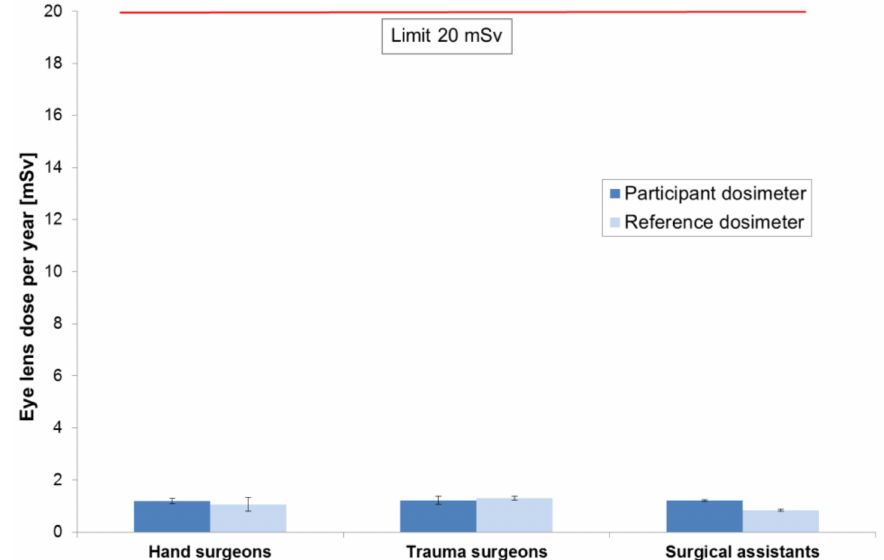
Figure 8. The mean of eye lens dose of the three participant groups (mid-blue) before deduction of the zero e ff ect (measuring point measuring institute LPS) each compared to the mean and standard deviation of the reference dosimeter dose (light blue). The graphic is scaled to the eye lens dose limit of 20 mSv (red line). The values are extrapolated to 1 year. Table 2. Annual radiation exposure. Hand Surgeons Trauma Surgeons Surgical